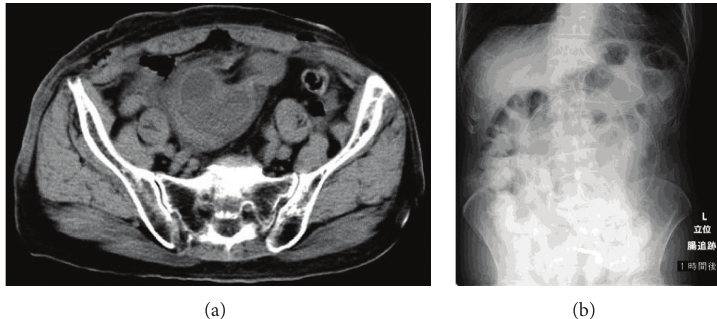
Figure 2: (a) A cyst-like bowel loop is visible in the pelvic cavity. Bowel obstruction is not complete, and localized adhesion of the small bowel is thought to be due to repeated prolapse and incarceration over many years. (b) Abdominal X-ray image 1 hour after injection of contrast agent from the ileus tube. Contrast agent has reached the colon, the small bowel is not dilated, and bowel obstruction has improved.